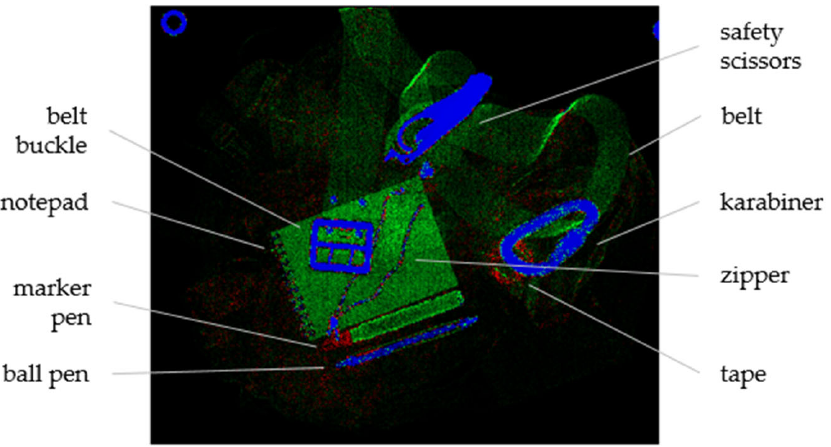
Figure 5. False-colored combination of the material images shown in Figure 4; red indicates Z eff = 6 (plastics), green indicates Z eff = 11.2, and blue indicates Z eff = 26 (iron). Adapted from [26], licensed under CC BY 4.0.